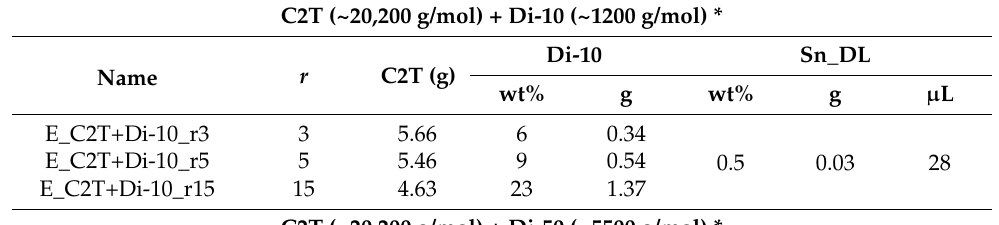
Table A3. Compositions of silicone elastomers for tensile, electrical breakdown strength, and scratch resistance